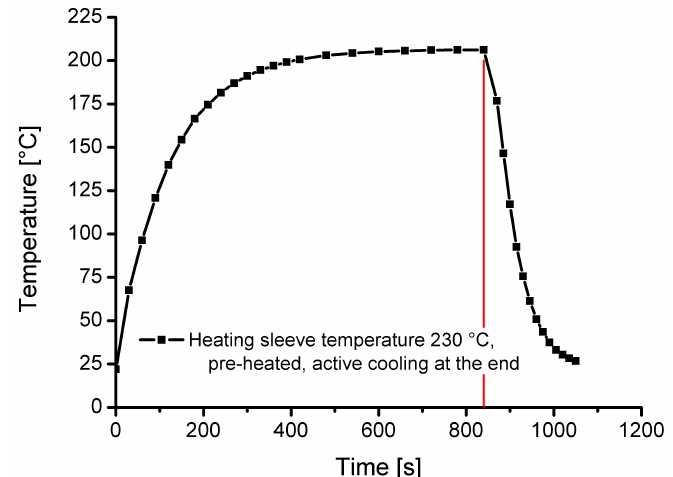
Figure 4. Heating and cooling curve for a charging temperature of 200 ◦ C .